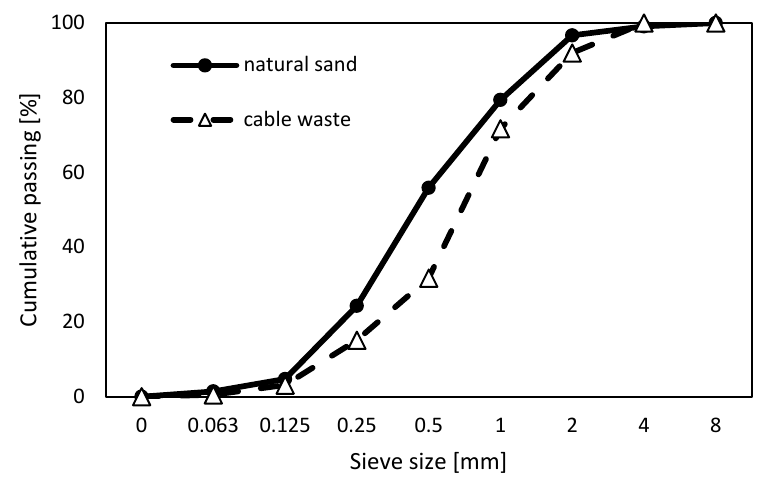
Figure 1. Cumulative passing of studied cable waste and replaced natural sand.